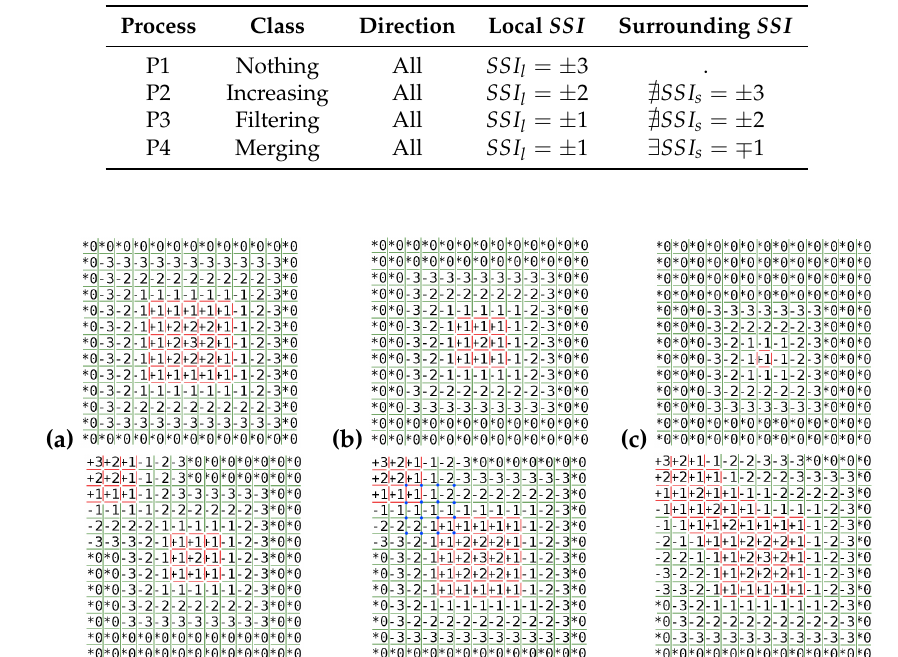
Table A1. Modifications of the horizontal obstacle size depending on the Surface State Index ( SSI ).